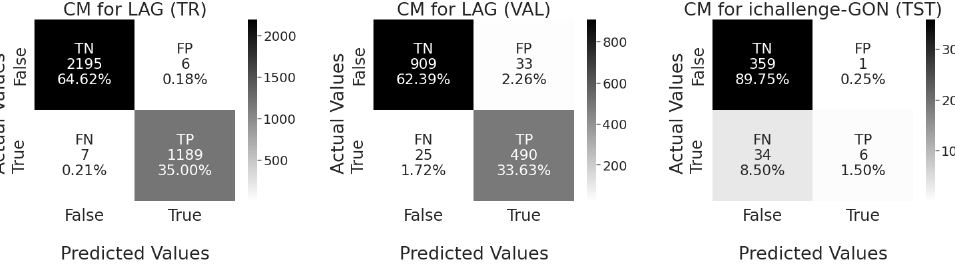
Figure 4. Confusion matrix of MobileNet_v2 trained parameters for